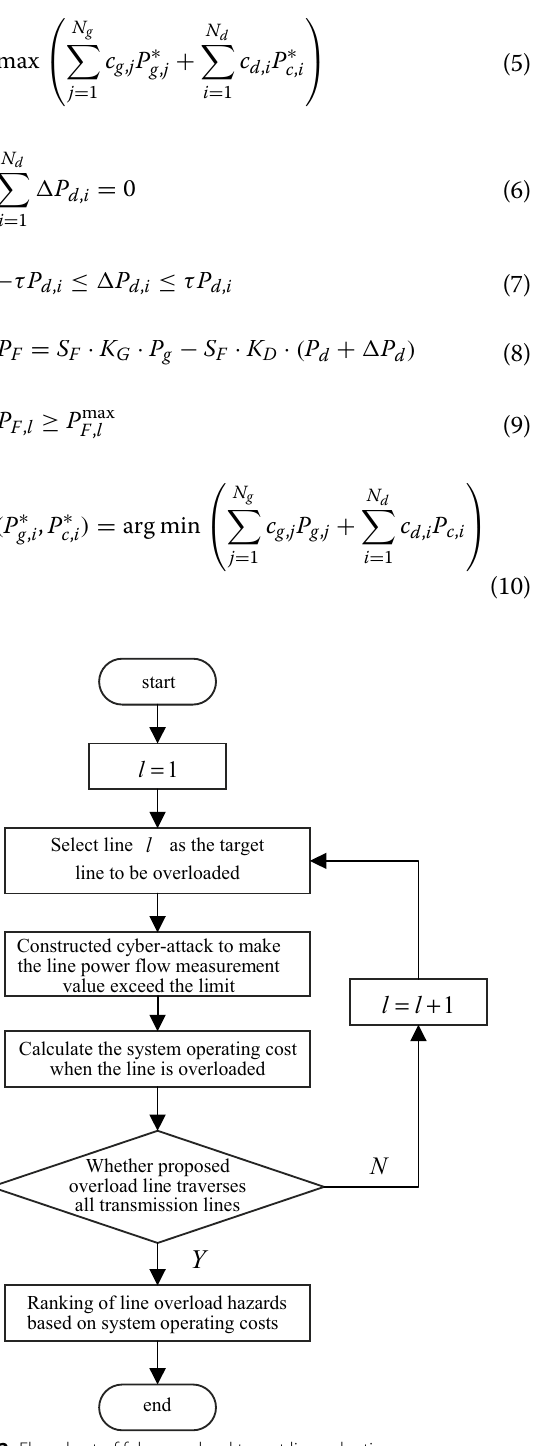
Fig. 2 Flowchart of false overload target line